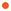
Oxyhemoglobin concentrations (ΔO2HbAVG) as a function of trials.Average values across all participants (N = 10) for left (●) and right (●) prefrontal cortex (PFC) subregions (top to bottom panels) as a function of the trial number: A) Left and right dorsolateral PFC (DLPFCL/R); B) Left and right ventrolateral PFC (VLPFCL/R); C) Left and right frontopolar PFC (FPFCL/R); D) Left and right orbitofrontal cortex (OFCL/R). Error bars correspond to the standard error of the corresponding means. Piecewise linear regressions (---) use trial 3 as the break point (see bottom graph and text for justification). *** p < 0.0001.